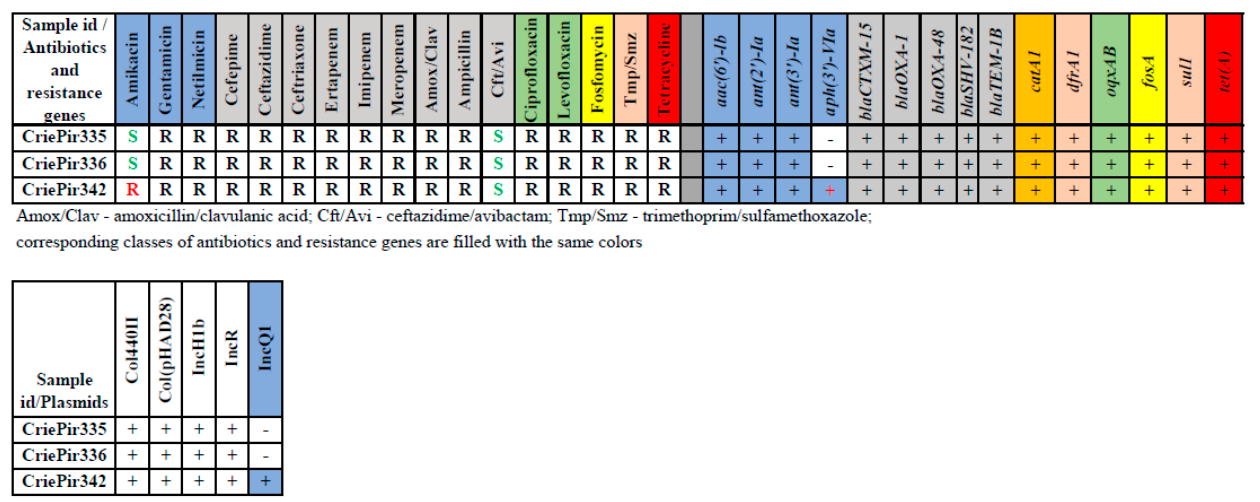
Figure 1. Phenotypic and genomic antibiotic resistance profiles of clinical K. pneumoniae isolates obtained from COVID-19 patients.